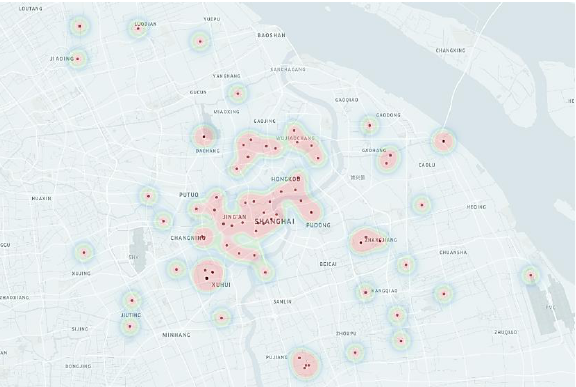
Figure1. main urban agglomerations of coworking spaces in